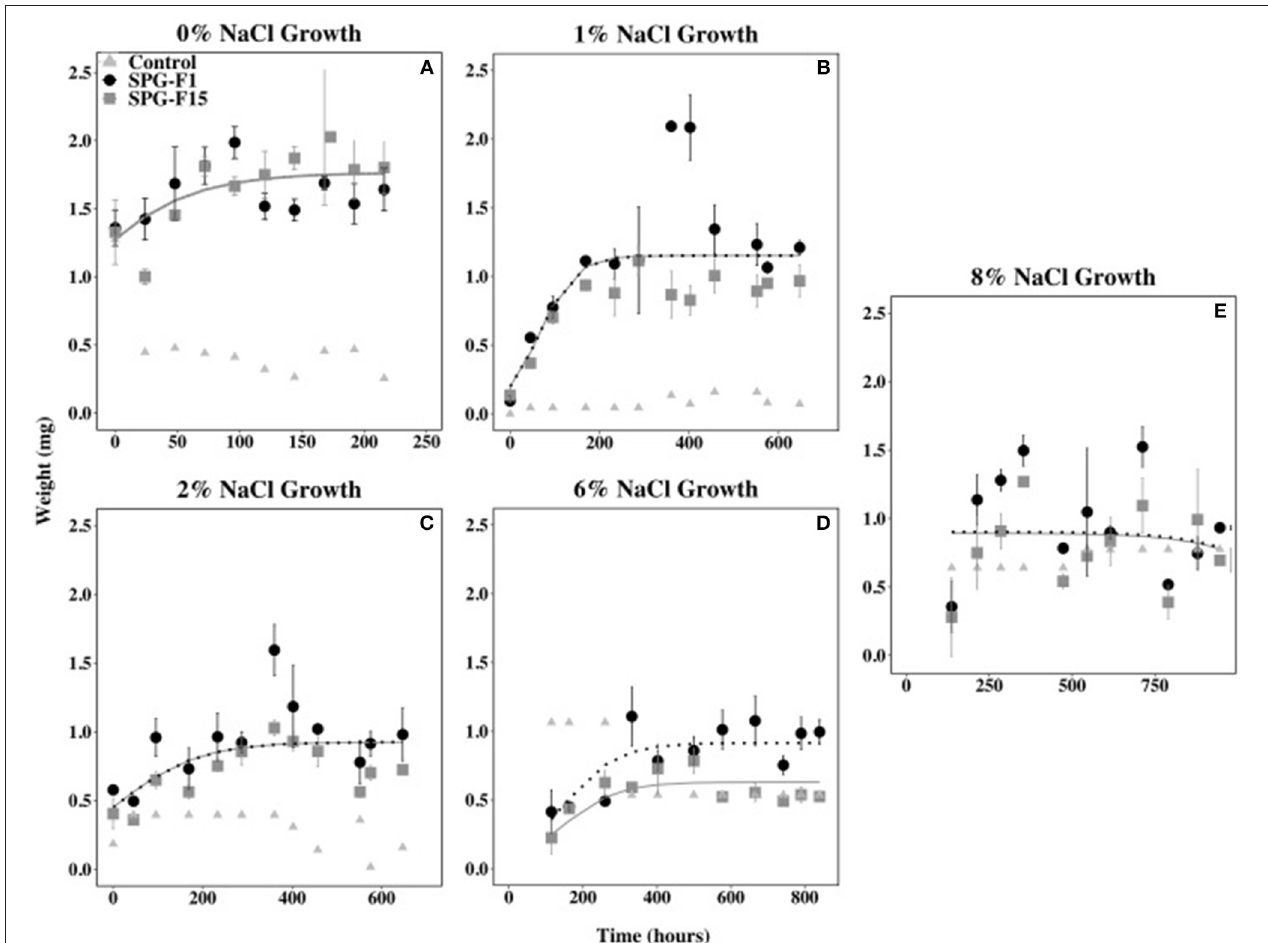
FIGURE 6 | Effect of salinity on SPG-F1 and SPG-F15 growth, measured in mg over time. (A) 0% NaCl growth. (B) 1% NaCl growth. (C) 2% NaCl growth. (D) 6% NaCl growth. (E) 8% NaCl growth. Time point 0 for 6 and 8% NaCl were removed as they were outliers. Error bars represent standard error calculated for 3 biological